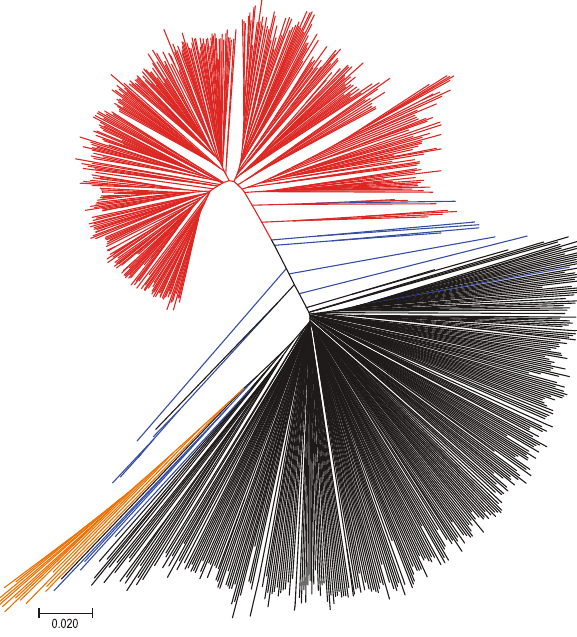
Fig. 1 Neighbor-joining tree of the 781 soybean accessions. The accessions were divided into four color lines: Glycine max is red, most of Glycine soja black, G. soja collected from the middle region of the Yellow River basin orange, and hybrids